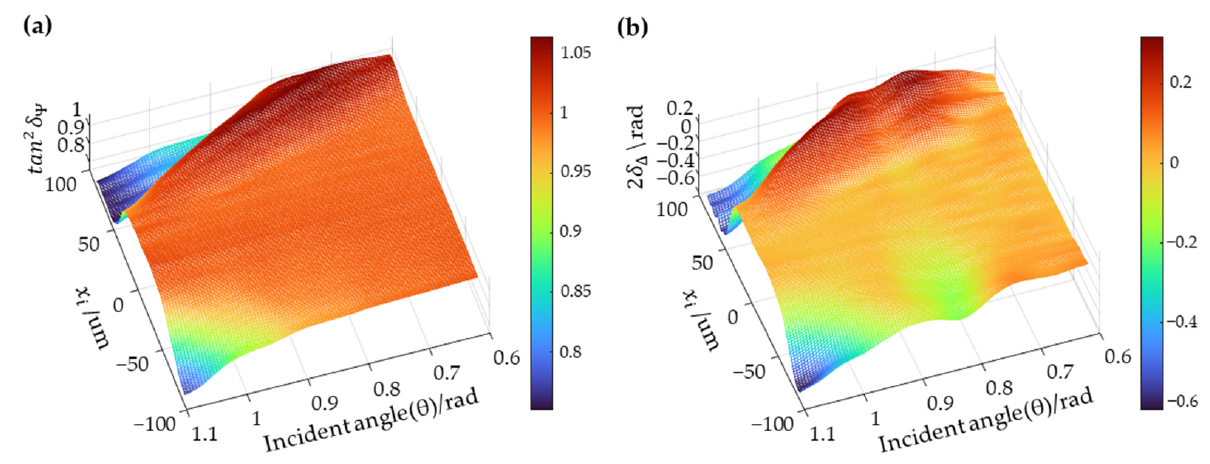
Figure 8. Calibrated ellipsometric maps of compensation ( a ) tan 2 δ Ψ and ( b ) 2 δ ∆ from a SiO 2 film. Finally, the maximum radius R , the frequency domain function value F , and the energy density NM of the 37 defocused BFP images were calculated for real-time defocus position determination, as shown in Figure